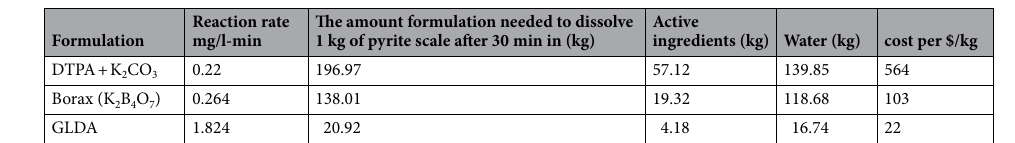
Table 3. Cost of removing 1 kg of pyrite using borax and DTPA/K 2 CO 3 formulations.